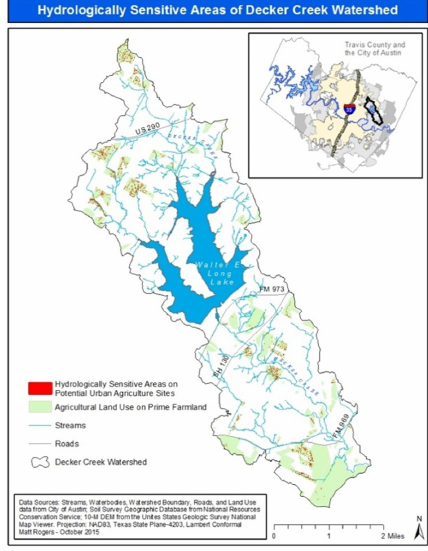
Figure 4. The spatial distribution of hydro- logically sensitive areas (HSAs) in Decker Creek Watershed in Austin, TX. HSAs in Decker Creek watershed have topo- graphic index (TI) values 1.5 standard de- viations above the mean or greater than 15. These particular HSAs are on poten- tial urban agriculture sites as determined by their location on land deemed agri- cultural by the City of Austin and consid- ered prime farmland by the National Re- sources Conservation Service (NRCS).